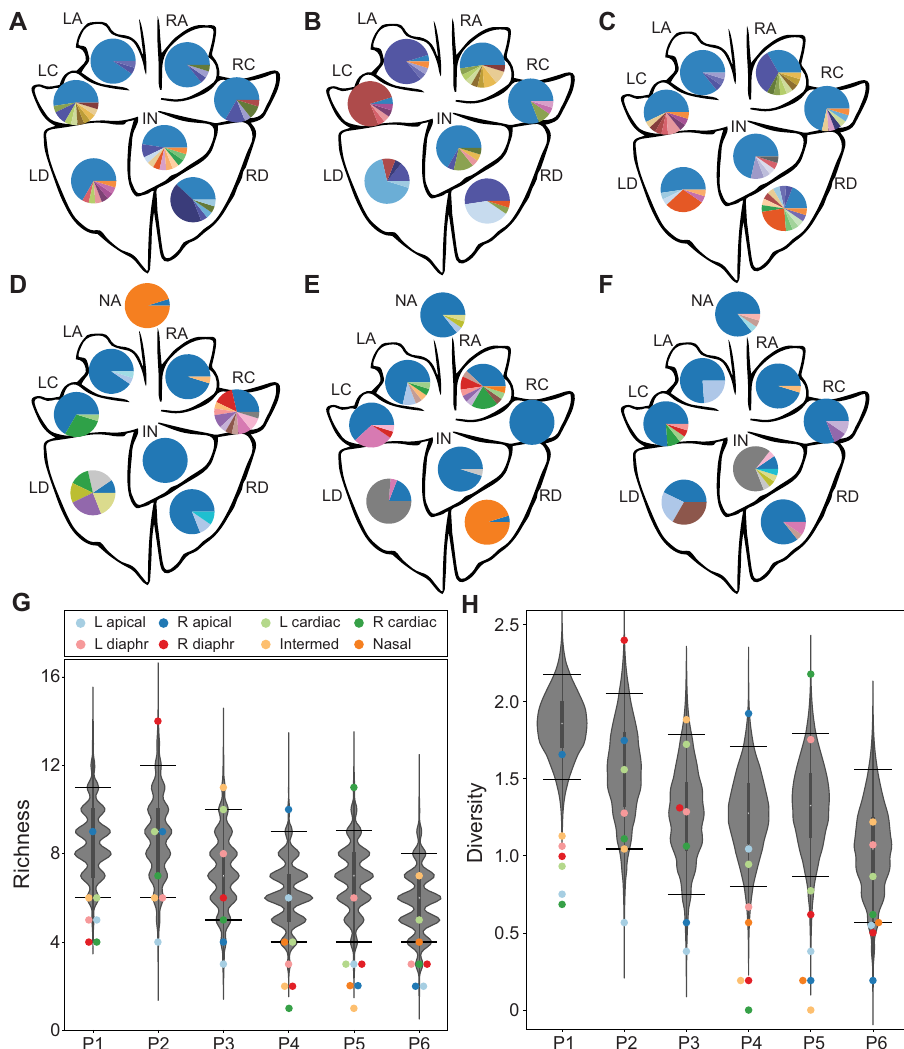
Fig.4|Localdiversityarisingthroughreassortmentismodestwithintheswine respiratory tract. Pie charts showing frequencies of unique genotypes present withineachlunglobeofagivenpigonday3( A – C )andthenasaltractandeachlung lobe of a given pig on day 5 ( D – F ) with blue and orange sections representing WT and VAR parental genotypes, respectively. The tissue sites are abbreviated as NA- Nasal; LA-Left Apical; RA-Right Apical; LC-Left Cardiac; RC-Right Cardiac; LD-Left Diaphragmatic; RD-Right Diaphragmatic; IN-Intermediate (accessory). Simulated richness ( G ) and diversity ( H ) are plotted, with observed results (colored points)